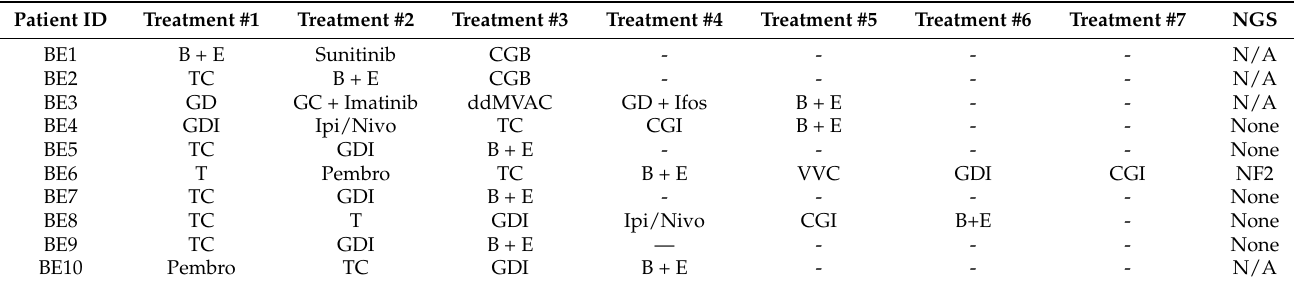
Table 2. Treatment regimen summary and tumor mutation analysis results.